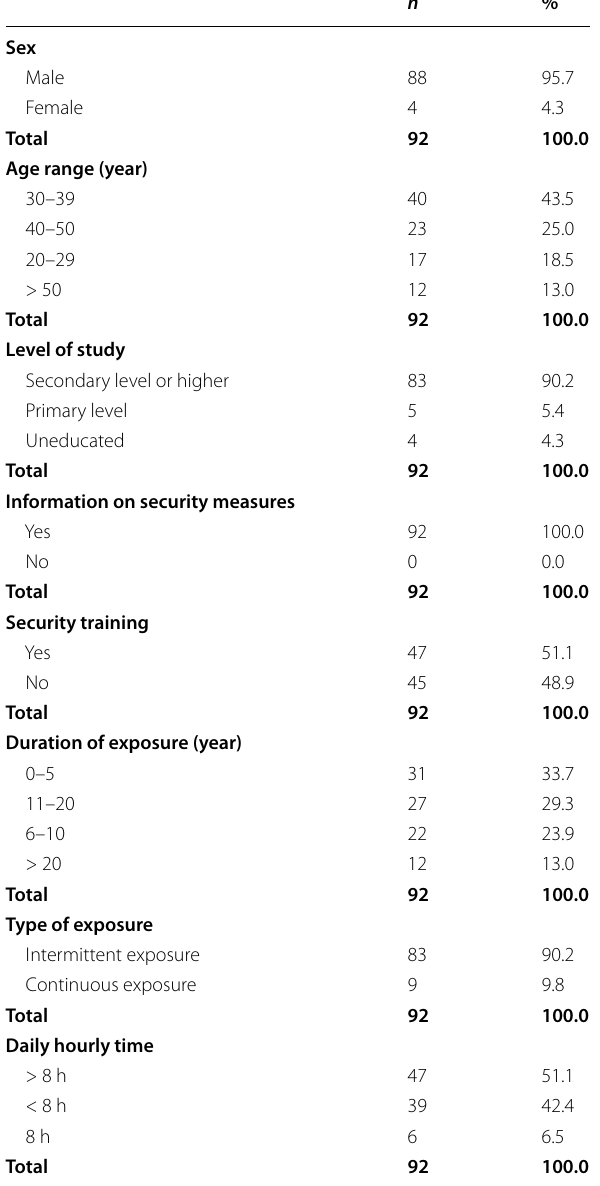
Table 1 Socio‑professional characteristics of workers